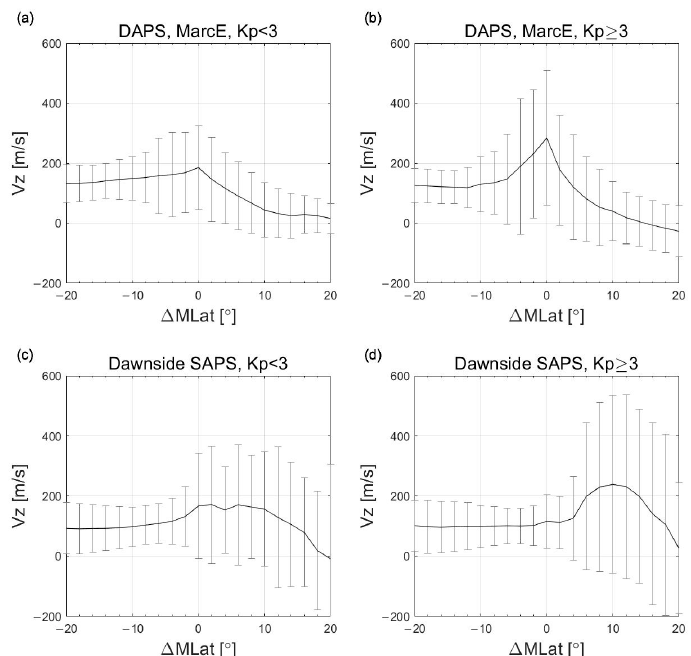
Figure 4. Superposed epoch analyses of the vertical flow velocity (Vz) for DAPS ( a , b ) at March equinox and dawnside SAPS events ( c , d ) without seasonal separation under different geomagnetic activity levels. The 0 key MLat denotes the latitude where the cross − track velocity (DAPS or SAPS) peaks. Positive values denote upward flow. The bars show the standard deviations of 2° averages. Table 3. The mean upflow velocities (Vz) at the latitudes where the DAPS and dawnside SAPS peak under two different Kp levels. The abbreviation MarcE denotes the March equinox, JuneS denotes the June solstice, SeptE denotes the September equinox, and DeceS denotes the December solstice. Upward Velocity, Vz (m/s) DAPS Dawnside SAPS